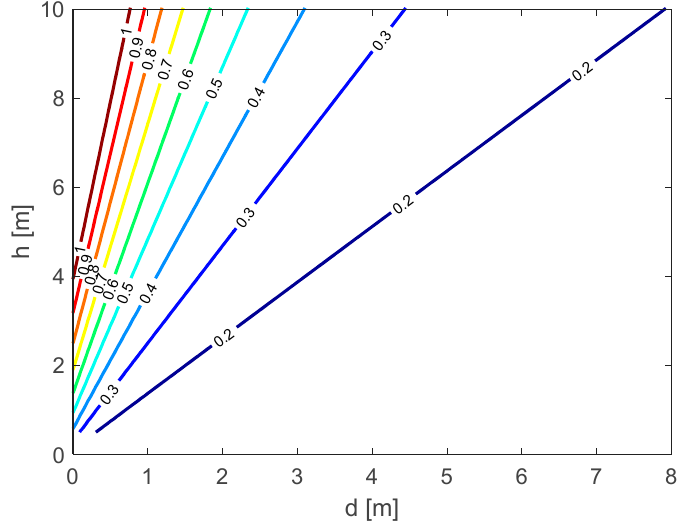
Figure 6. Contour plot of the across-track resolution ∆ y versus d and h , expressed in meters, in the case of a rectilinear flight trajectory